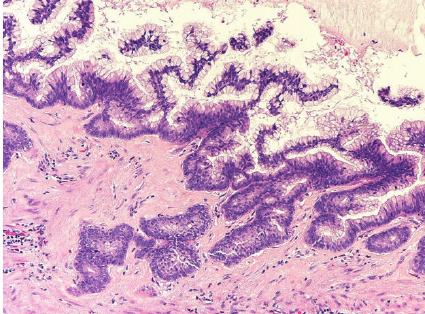
Figure 5: Photomicrograph showing low grade mucinous cys- tadenocarcinoma with nuclear pleomorphism and frequent mitotic figures (original magnification × 20, hematoxylin and eosin stain).